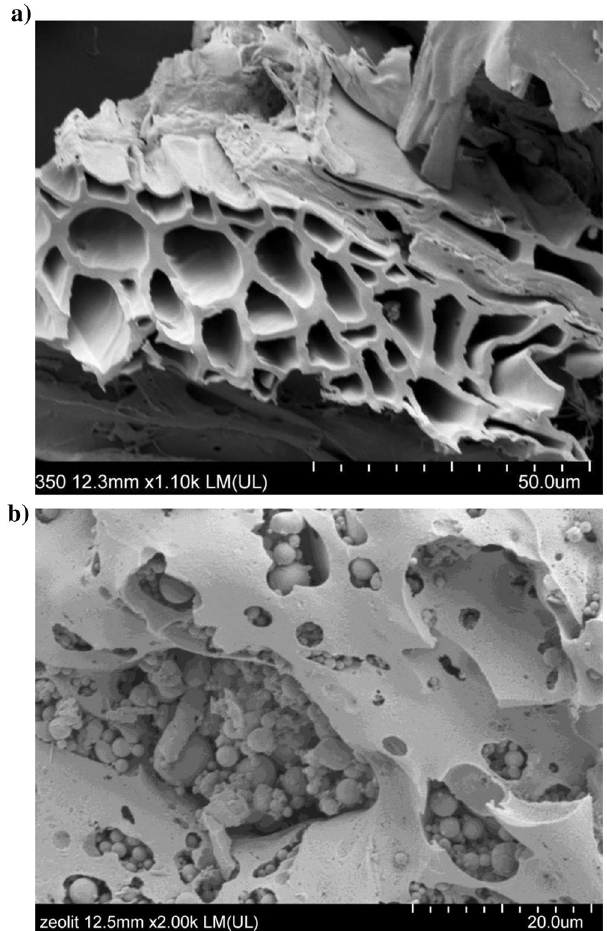
Figure 1. SEM images of ( a ) biochar produced from willow ( Salix ssp.), ( b ) zeolite synthesized from coal fly ash with Na-P1